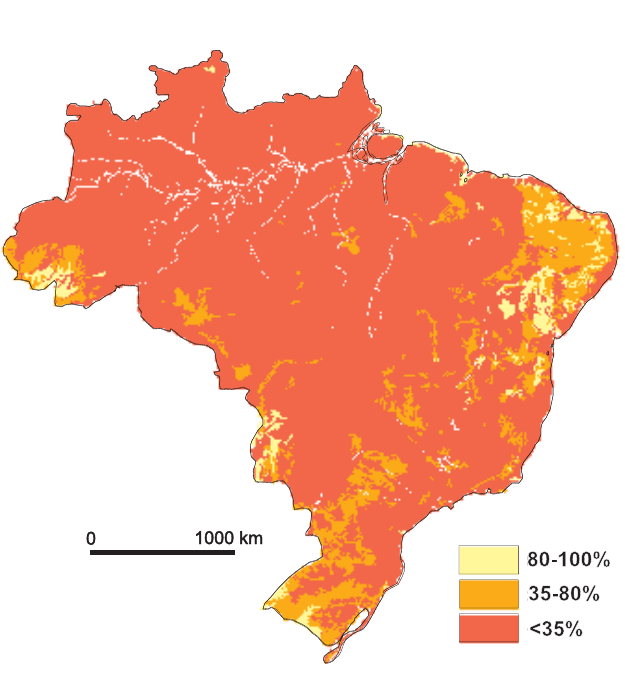
Fig. 3 – Distribution of base saturation (BS) values in Brazil.